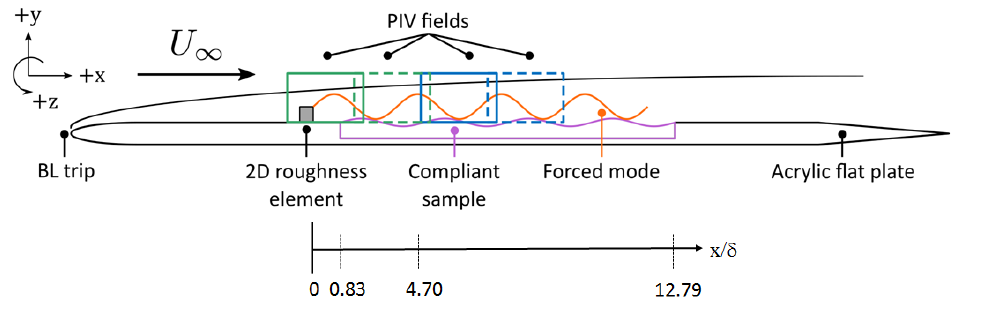
Figure 1. Illustration of the experimental setup. The rectangles representing the PIV fields are not true to scale or aspect ratio, but represent the FOVs of the two cameras and the streamwise shift (green locations to blue locations) between setups required to obtain the long spatial field of view reported here. The phase-averaged vector fields were stitched together in post-processing. Mean statistics are reported from x / δ = 4.70, and streamwise locations of the LE and TE of the compliant panel are also shown. The illustration is vertically reflected relative to the physical setup, i.e., measurements are made on the bottom surface of the flat plate.